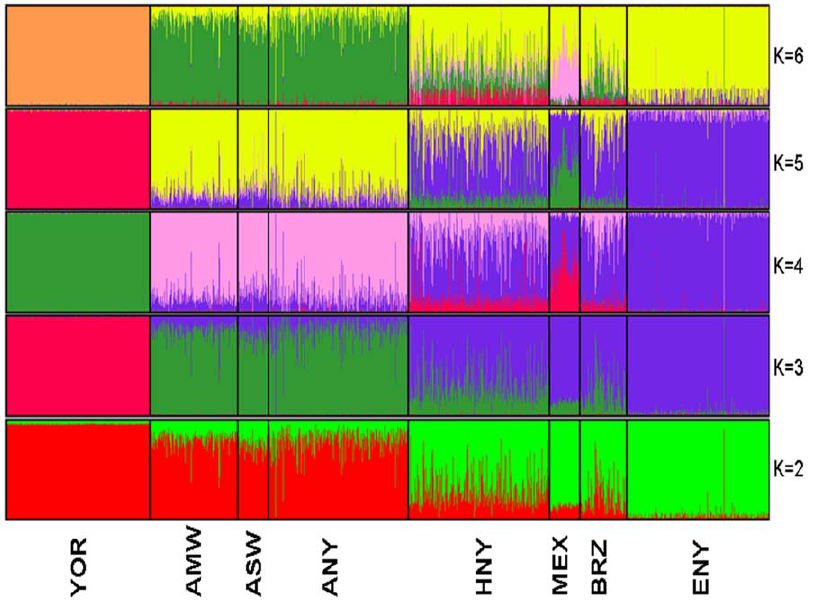
Figure 3. Population structure results for ancestral populations K =2 to K =6. Each subject is represented by a thin vertical line colored in proportion to their estimated ancestry within each cluster. The colors represent the proportion of inferred ancestry from each of the ancestral populations within each specific K value. Abbreviation for samples: African American biobank sample (ANY); European American biobank sample (ENY); Hispanic American biobank sample (HNY); African ancestry in Southwest USA (ASW); Mexican ancestry in Los Angeles, California (MEX) ; Yoruba from Nigeria (YOR); African American from Maywood, Illinois (AMW); Brazilians from Brazil (BRZ).